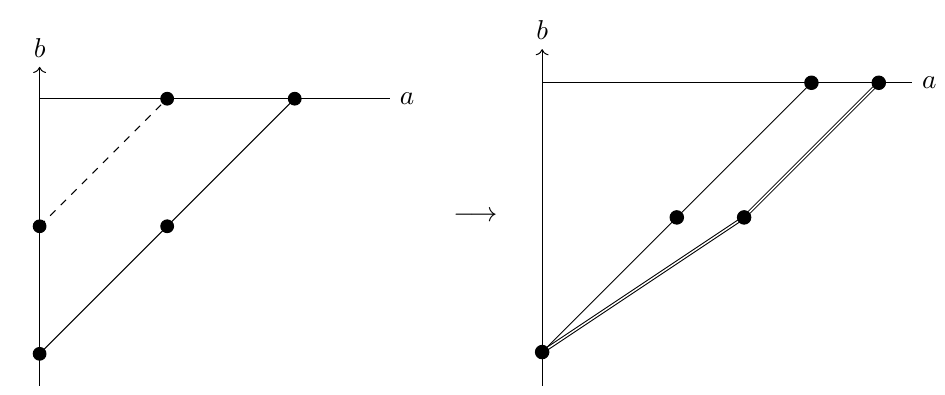
Figure 2 . One typical configuration of the Newton diagram generated by a G 4 -flux containing two different d ’s. In the left figure, we superpose all Newton diagrams of ˜ F d, ˜ n corresponds to ˜ F ˜ of the highest ˜ d , and the dashed line corresponds a possible lower d . On the d, ˜ n ˜ d right we show the end result. The double lines correspond to the Newton polygon of ˜ F . In the situation shown in this figure, the two segments of the Newton polygon have both positive slopes, indicating an axion backreaction behavior (4.30) that drives one into the regime of the Distance Conjecture.